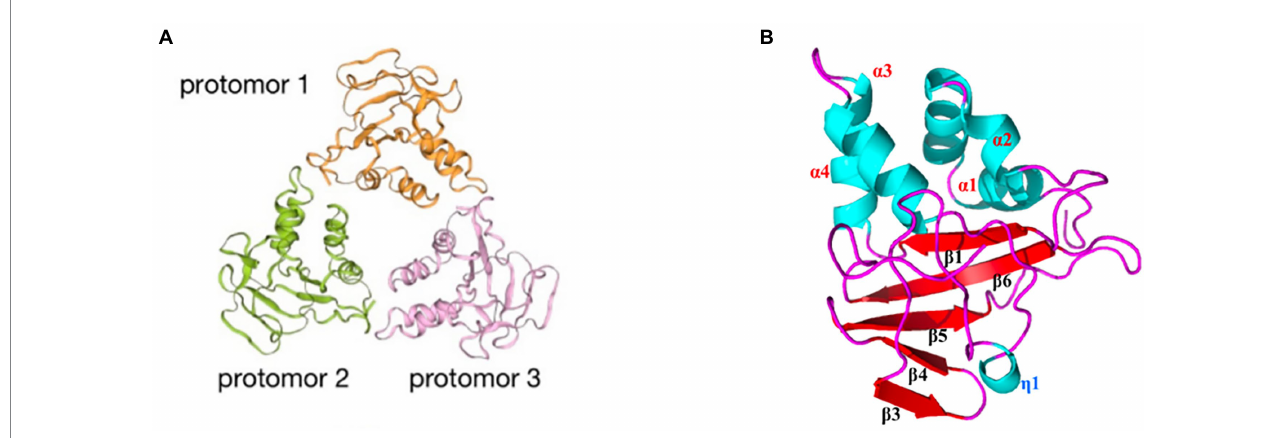
FIGURE 4 Schematic diagram of the ASFV p15 structure. (A) The trimeric structure of the p15 protein. Orange: protomer 1; green: protomer 2; pink: protomer 3. (B) Distribution of α -helices and β -sheets in the p15